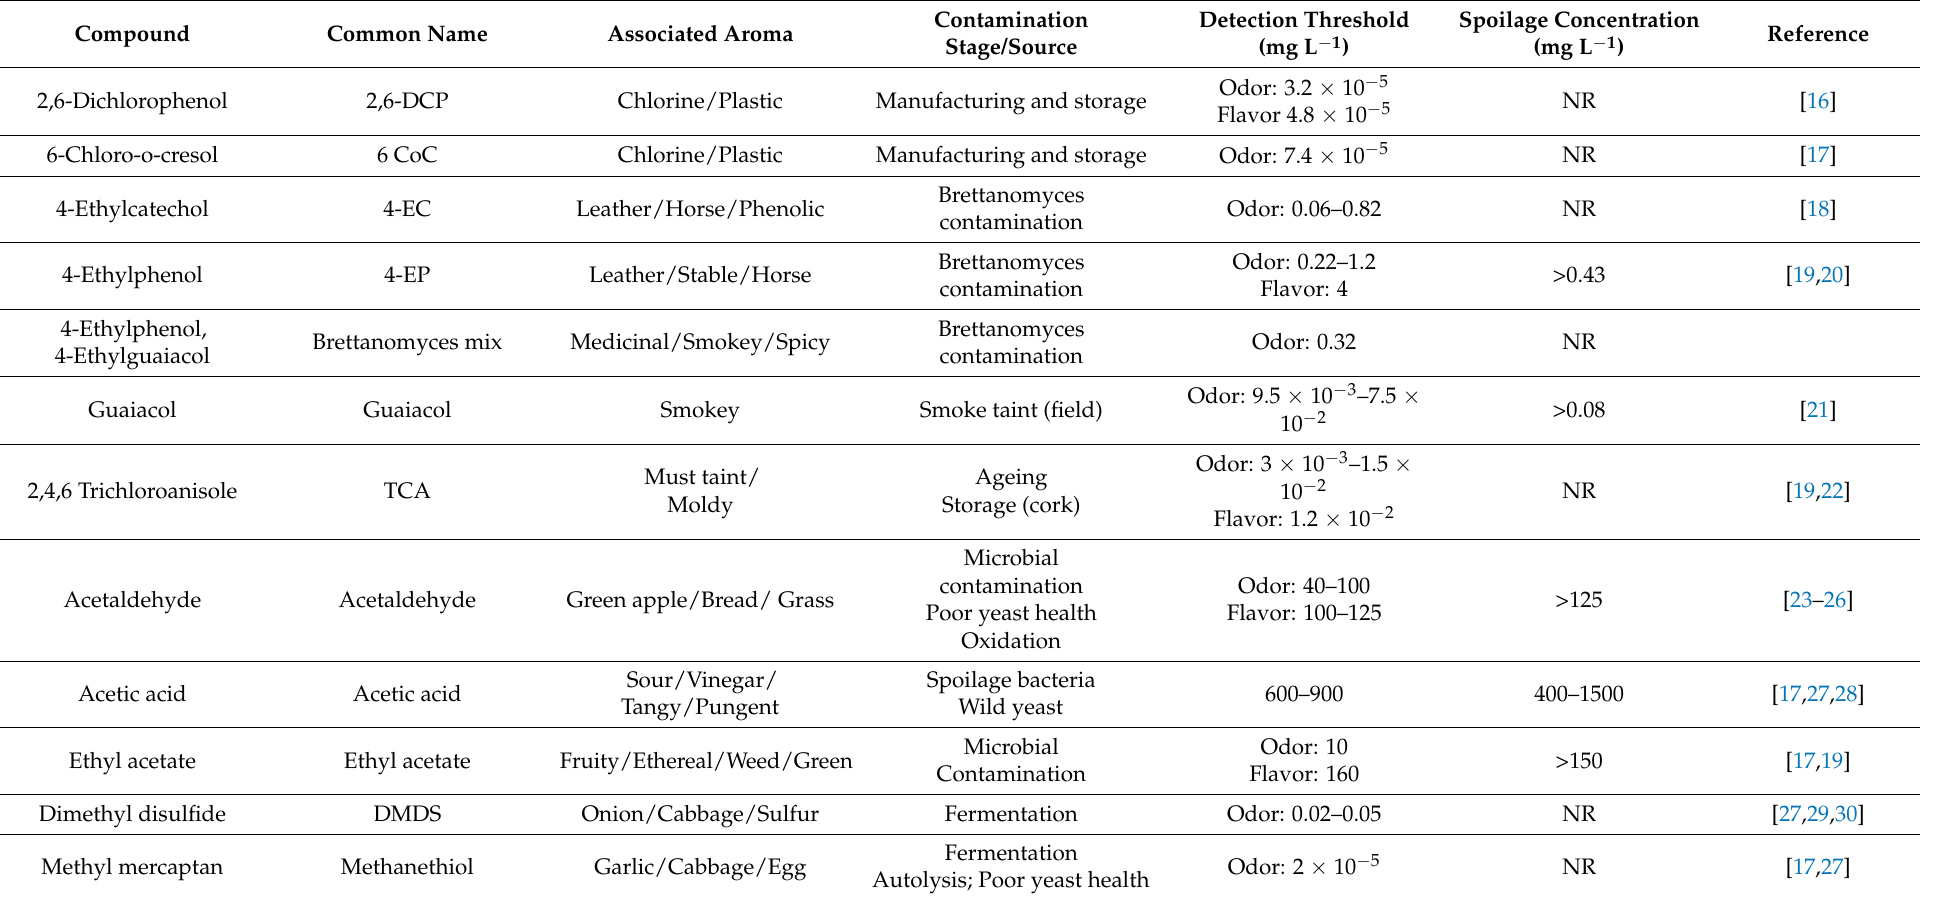
Table 1. List of common faults found in wine, their associated aroma, contamination stage within the production line and concentration information. NR: Not